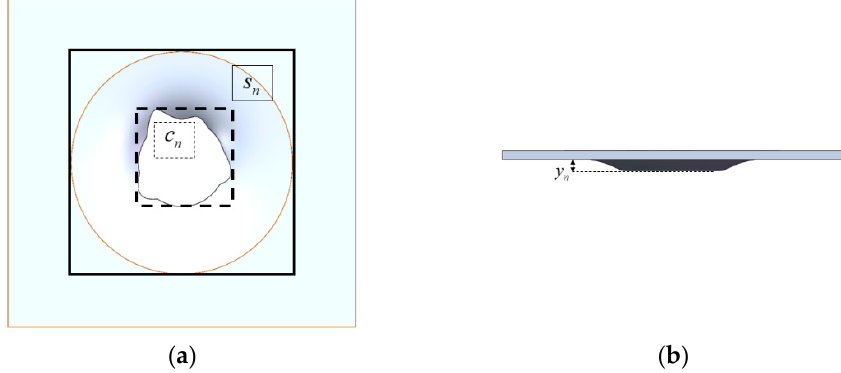
Figure 9. Evaluation of impact on plates: ( a ) top view; ( b ) side view: c n , s n and y n for the perforation area, deformation area and deflection of plate n, respectively.